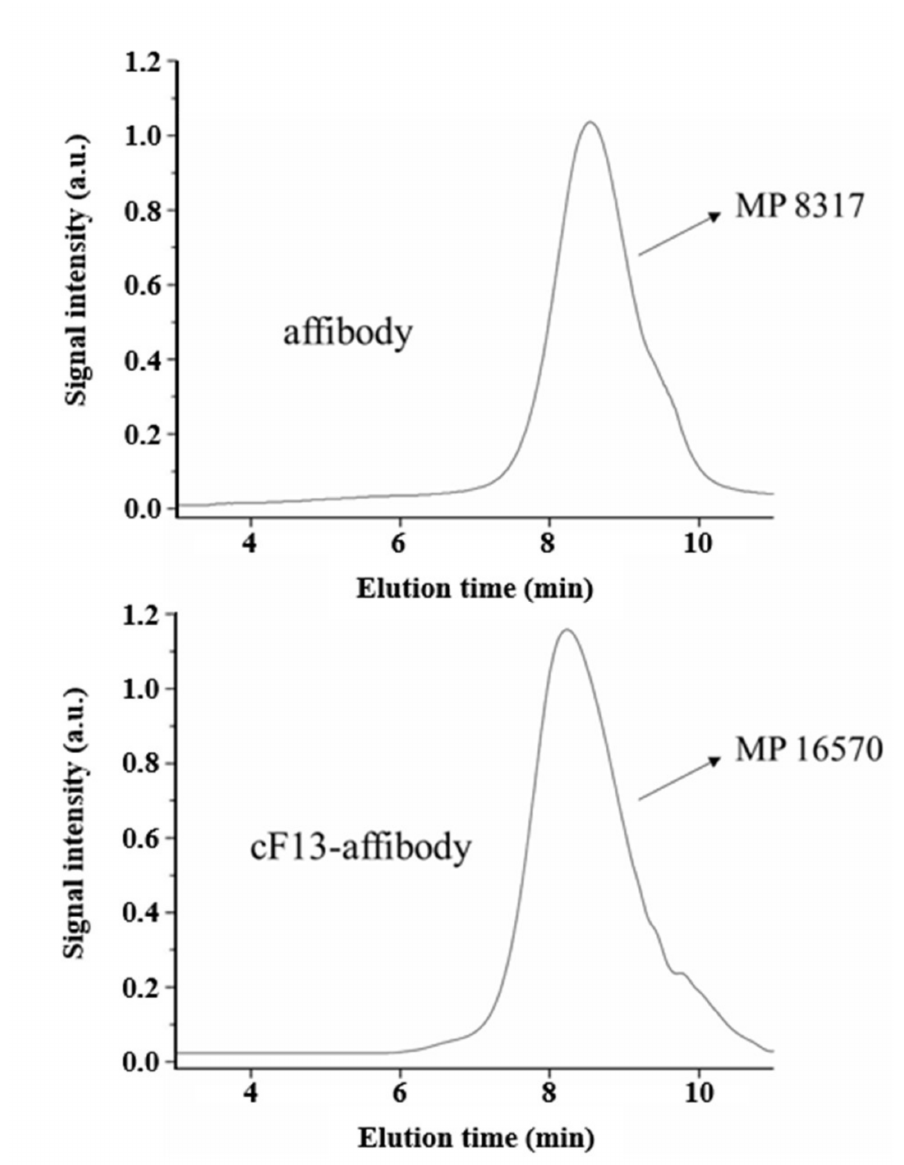
Figure A4. GPC traces and molar mass distribution characteristics of affibody and cF 13 -affibody.